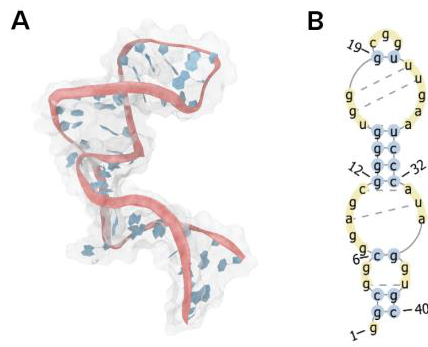
Figure 4. ( A ) Generated image of MApta pro with VMD software. ( B ) Derived secondary structure topology resolved and encoded by Elimination Max-Conflicts algorithm. Image generated by PseudoViewer-based procedure (RNApdbee).